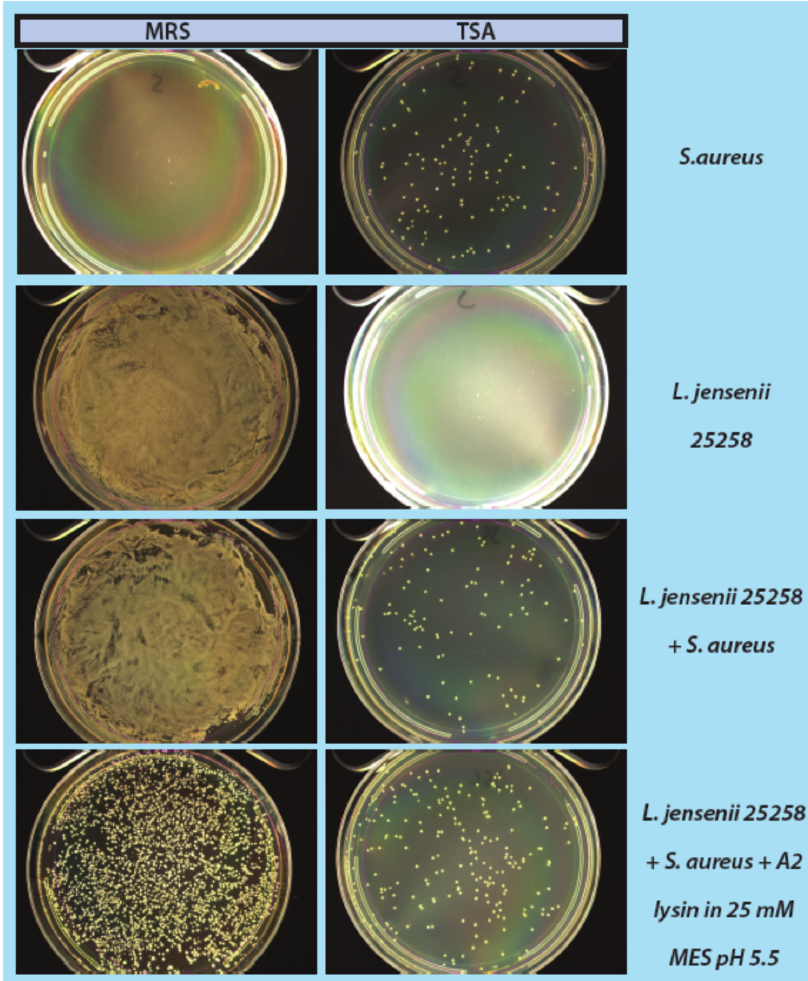
Figure 6. Mock purity assay, using L. jensenii as our mock product strain, and spiked with S. aureus N315 as a contaminant. High desnity L. jensenii cells were spiked with low numbers of S. aureus N315. Samples incubated with LysA2 showed L. jensenii growth, allowing for the clear recovery and detection of contaminating S. aureus colonies. Samples treated with LysA2 and plated on TSA showed fewer background colonies of L. jensenii (barely visible pinpoint colonies) compared to samples not treated with LysA2. The larger colonies seen on the TSA plates post LysA2 treatment are all S. aureus . The identical sample plated on MRS agar does not allow for easy distinction of S. aureus from L. jensenii .